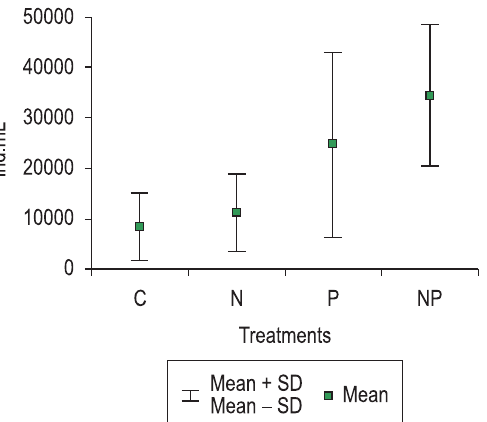
Figure 4. Algal density in different treatments of me- socosms installed in the Corvo river (Rosana reservoir). Control treatment (C); nitrogen treatment (N); phos- phorus treatment (P) and nitrogen plus phosphorus treatments (NP).